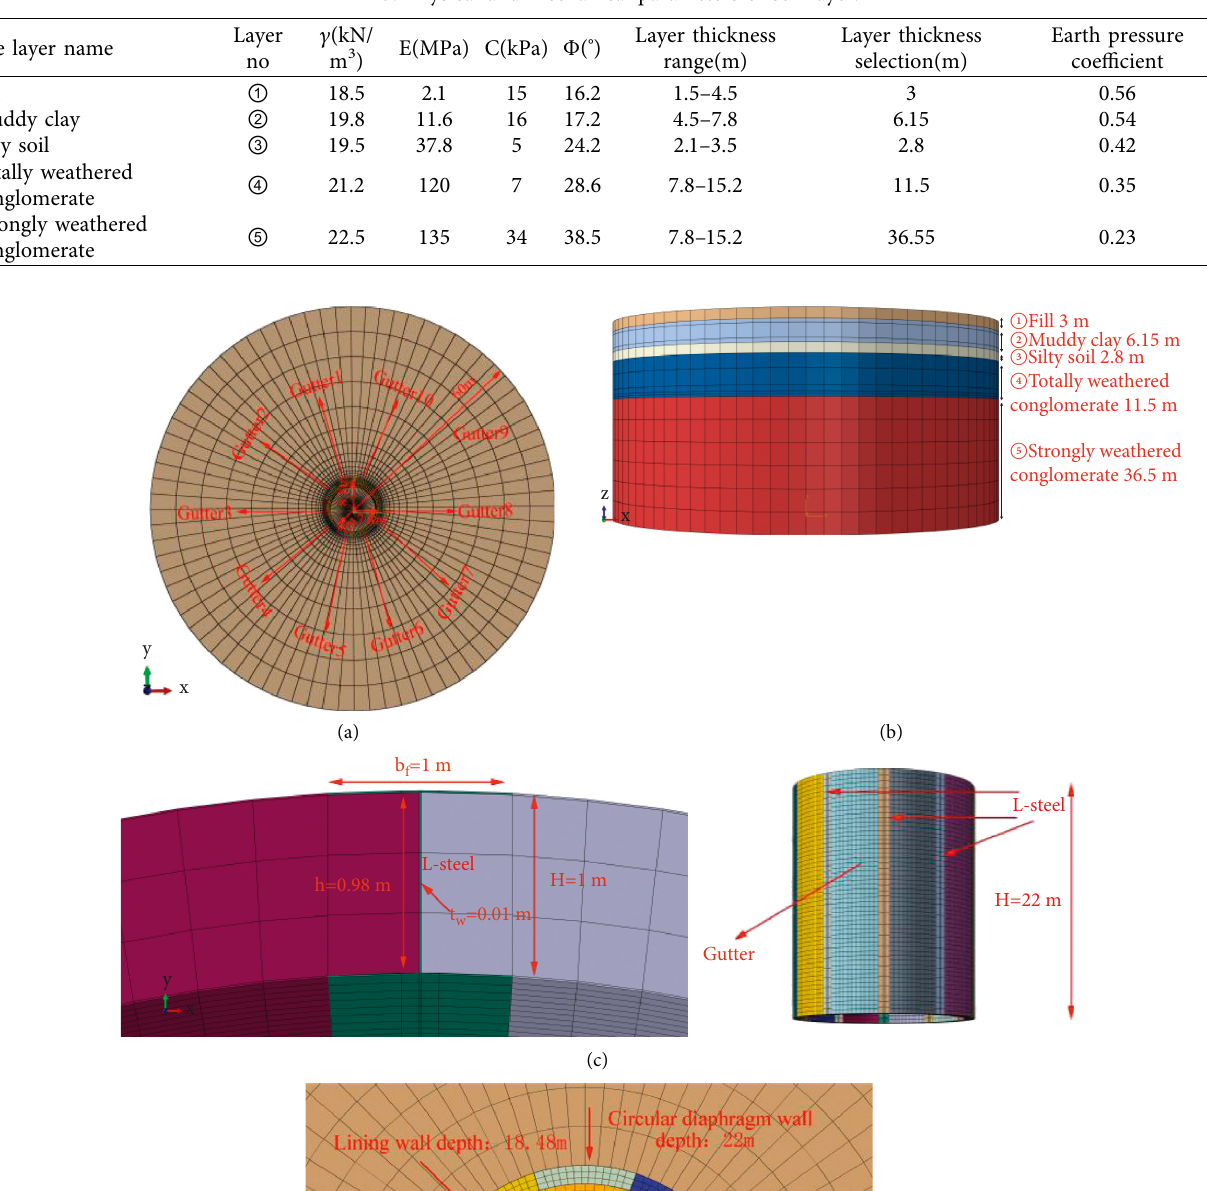
Table 3: Physical and mechanical parameters of soil layer.